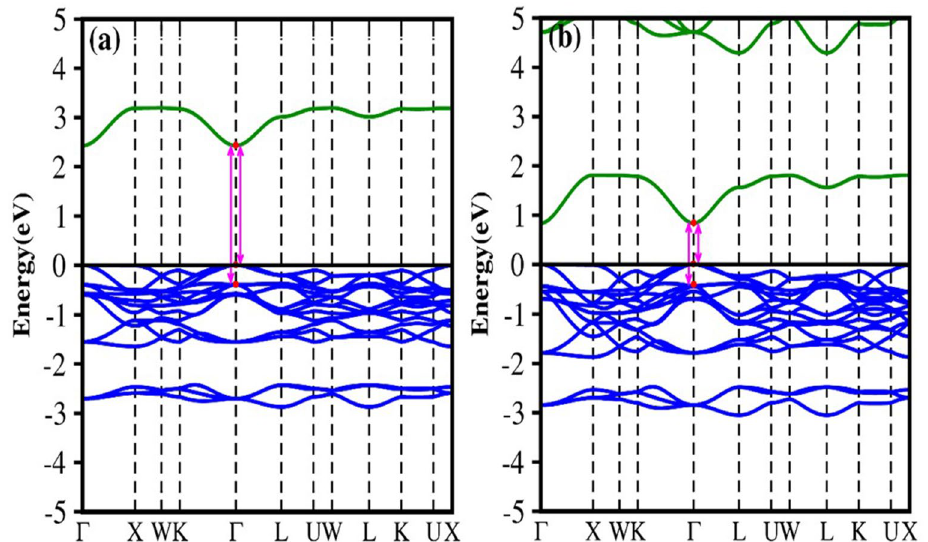
Figure 3. The calculated band structure of ( a ) Rb 2 SnBr 6 and ( b ) Rb 2 SnI 6 with mBJ